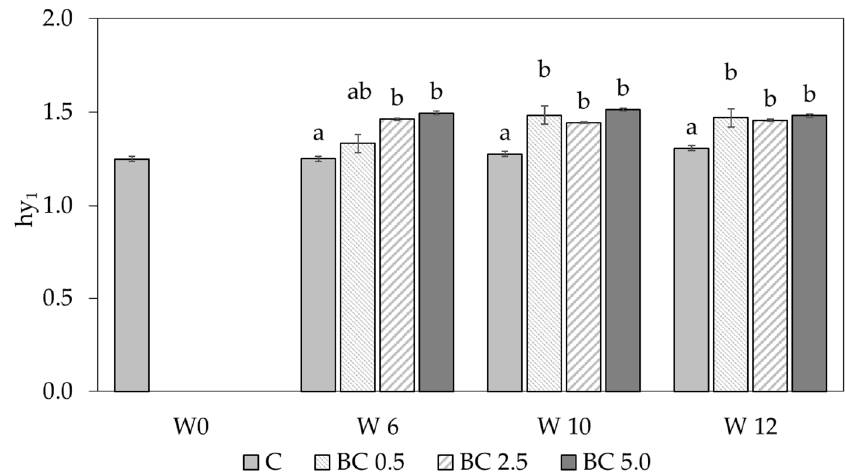
Figure 1. Changes in hygroscopic water content (hy 1 ) over time for the different treatments measured at constant 31.5% relative humidity and 20 ◦ C temperature. C, BC0.5, BC2.5, and BC5.0 represent control, 0.5%, 2.5%, and 5.0% biochar amended soil, respectively. Means denoted by the same letter did not significantly differ at p < 0.05; lowercase letters denote the comparison within biochar treatments.